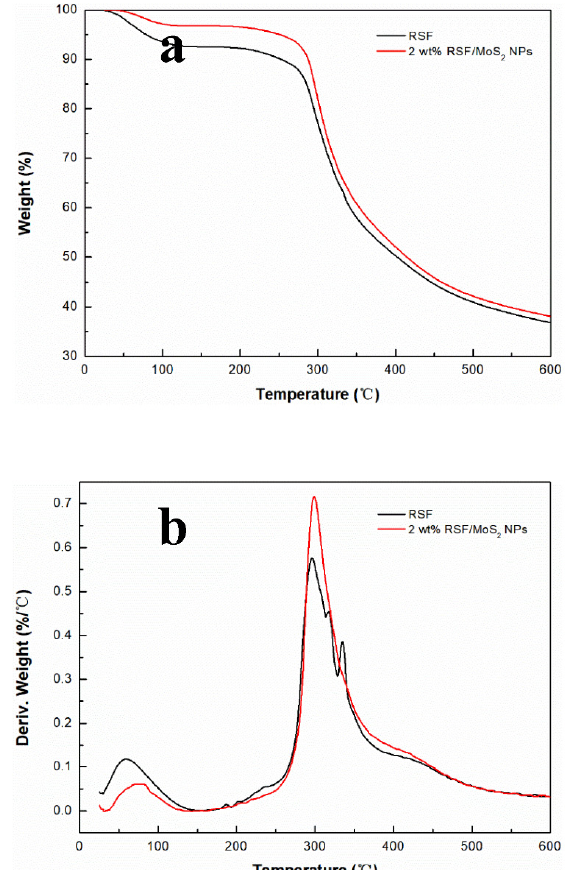
Figure 7. ( a ) TG curves of 2 wt% RSF/MoS 2 NPs hybrid fibers and RSF fibers; ( b ) DTG curves of 2 wt% RSF/MoS 2 NPs hybrid fibers and RSF fibers.